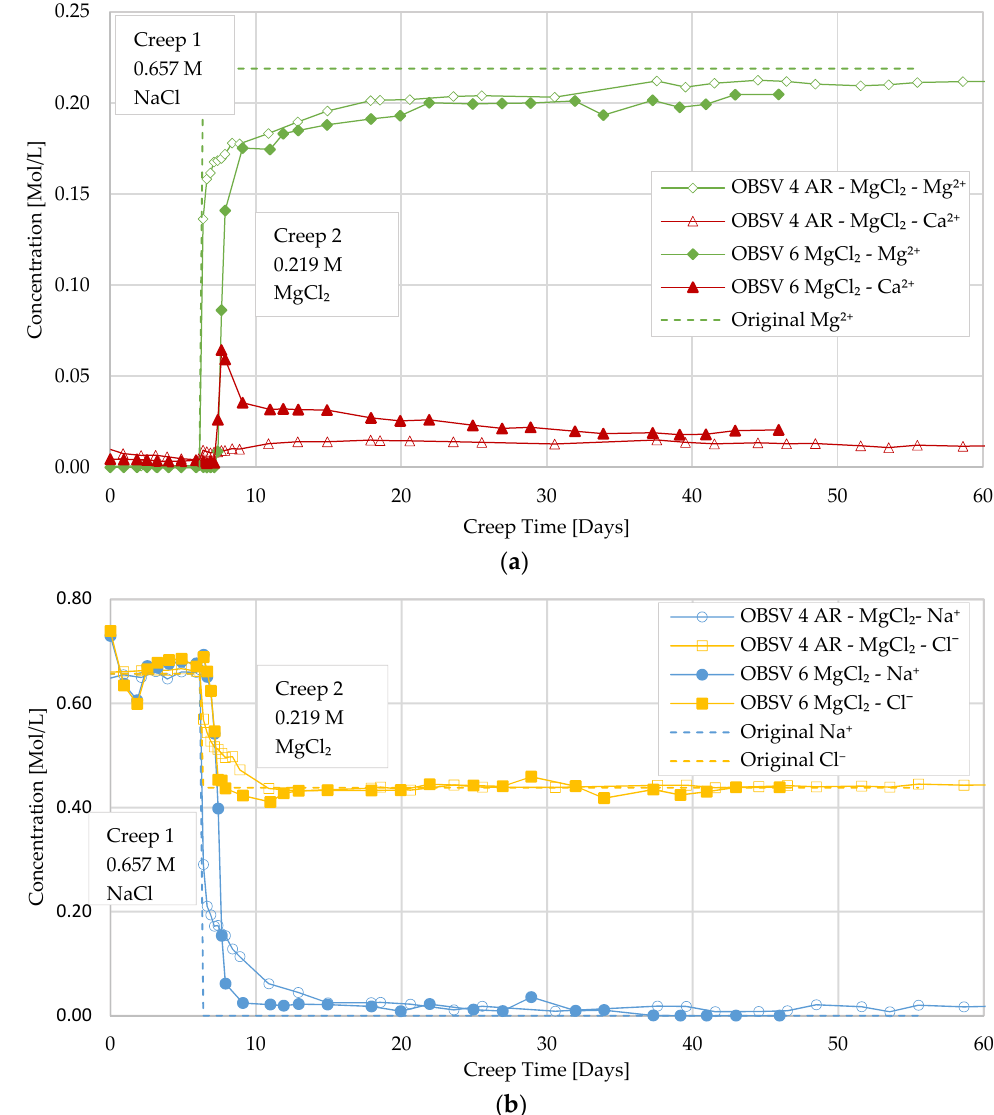
Figure 4. Effluent concentration for OBSV 4 AF-MgCl 2 and OBSV 6 MgCl 2 : ( a ) Effluent concentration of Mg 2+ and Ca 2+ for the artificially fractured and intact sample flooded with MgCl 2 (OBSV 4 AF- MgCl 2 and OBSV 6 MgCl 2 ). ( b ) Effluent concentration of Na + and Cl − for the artificially fractured and intact sample flooded with MgCl 2 (OBSV 4 AF-MgCl 2 and OBSV 6 MgCl 2 ). SSW-flooded samples (OBSV 9 SSW and OBSV 12 AF-SSW) experienced a similar yet less significant response of Ca 2 ⁺ dissolution and Mg 2 ⁺ retention observed for the unfrac- tured and artificially fractured cores flooded with MgCl 2 in start of Creep 2 (Figure 5).